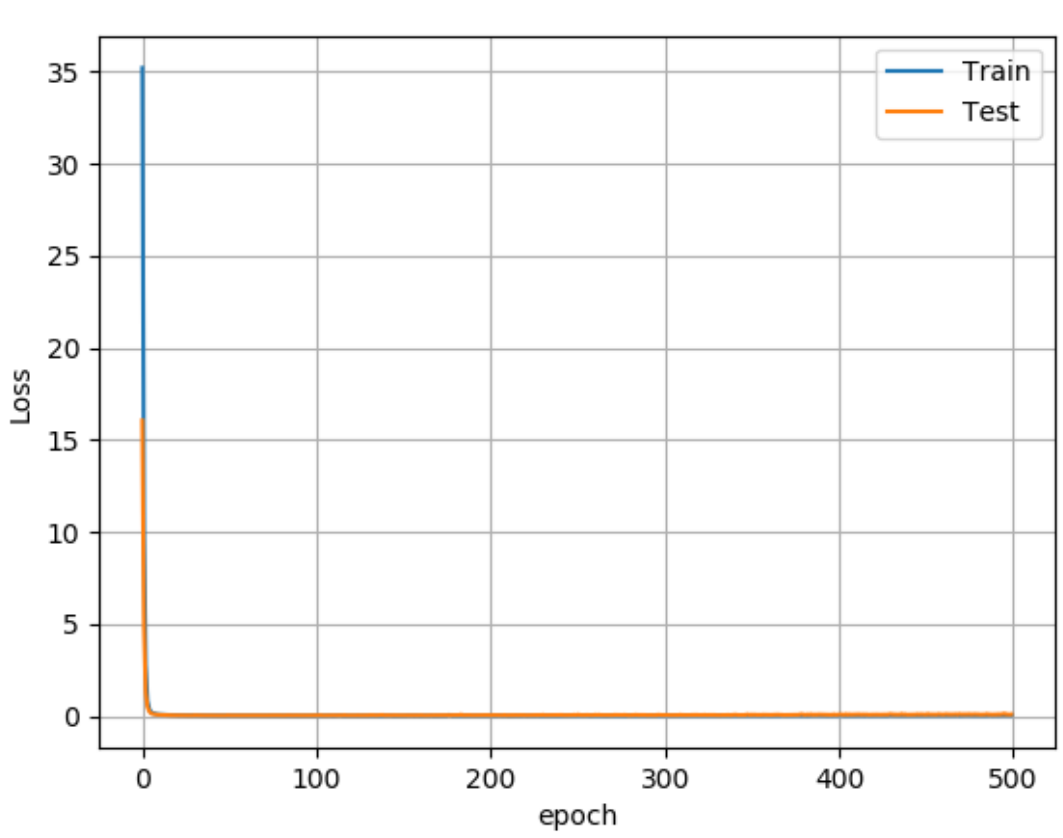
Figure 7. Loss of MLP